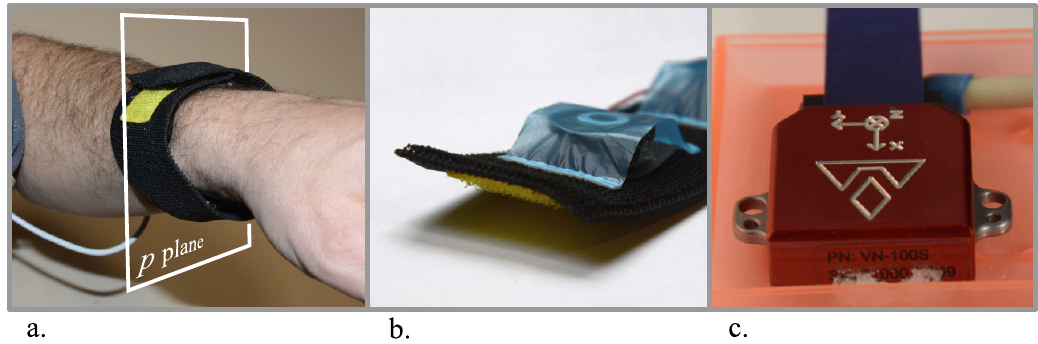
Figure 6. Peripheral elements of the teaching system. ( a ) Actuator: the band built on the base of an elastic hook-and-loop strip. ( b ) Actuator’s units (behind a protective film). ( c ) VN-100 inertial